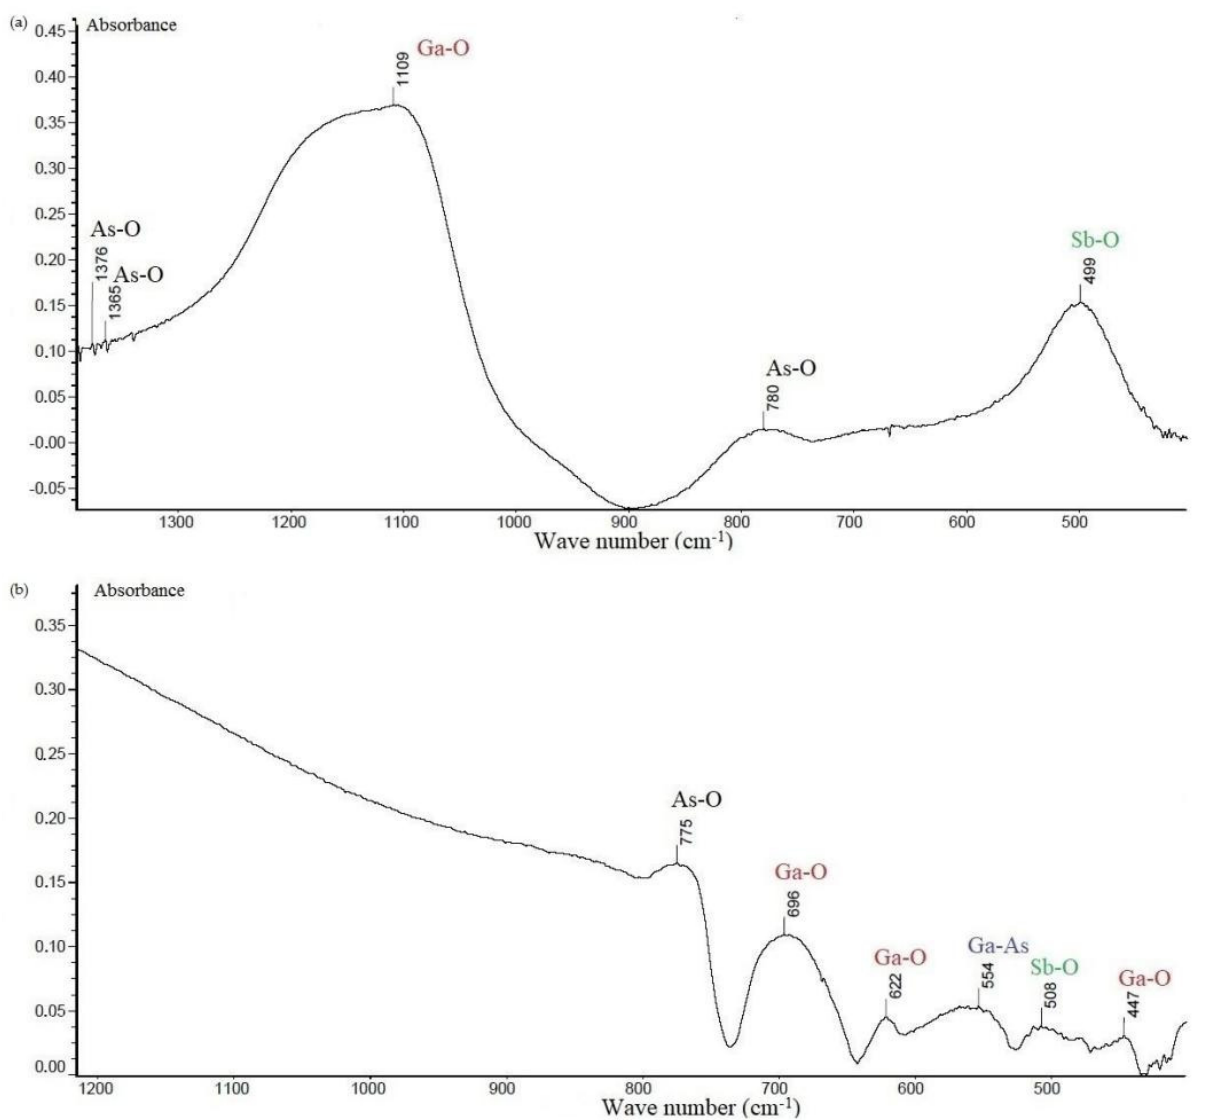
Figure 1. IR absorption spectrum of a film on a GaAs surface obtained under the influence of compositions ( a )—(Y 2 O 3 ) 0.8 (Sb 2 O 3 ) 0.2 , ( b )—(Y 2 O 3 ) 0.2 (Sb 2 O 3 ) 0.8.